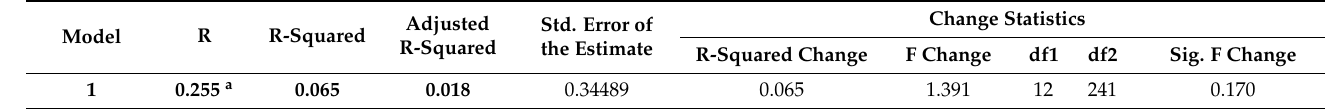
Table 8. Model summary.